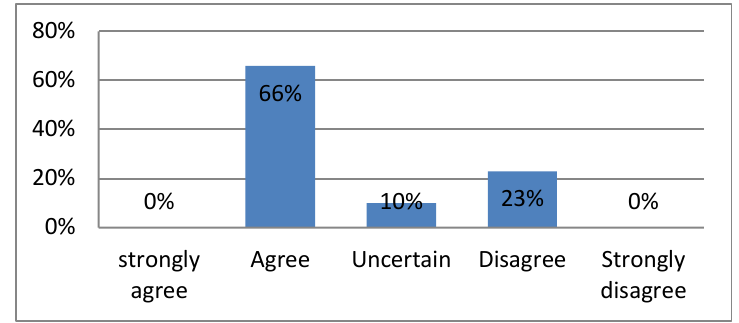
Figure 1 : purchase a product after seeing the advertisement